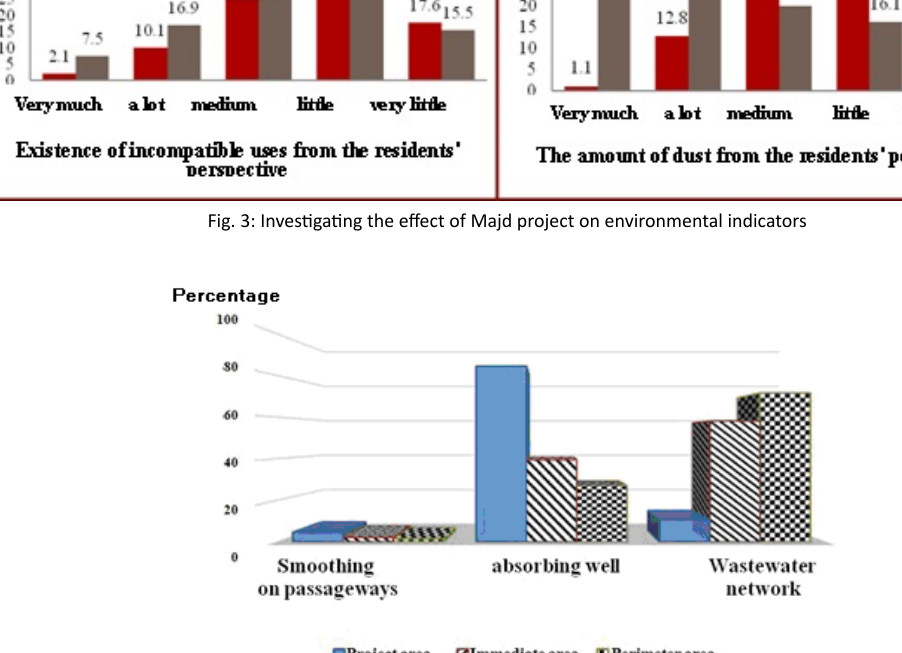
Fig 4: Wastewater disposal in the study area Fig. 4: Wastewater disposal in the study that in addition to increasing environmental pollution, it has caused distress to visitors and will prevent the development of attracting tourists to the region (Fig. 4).